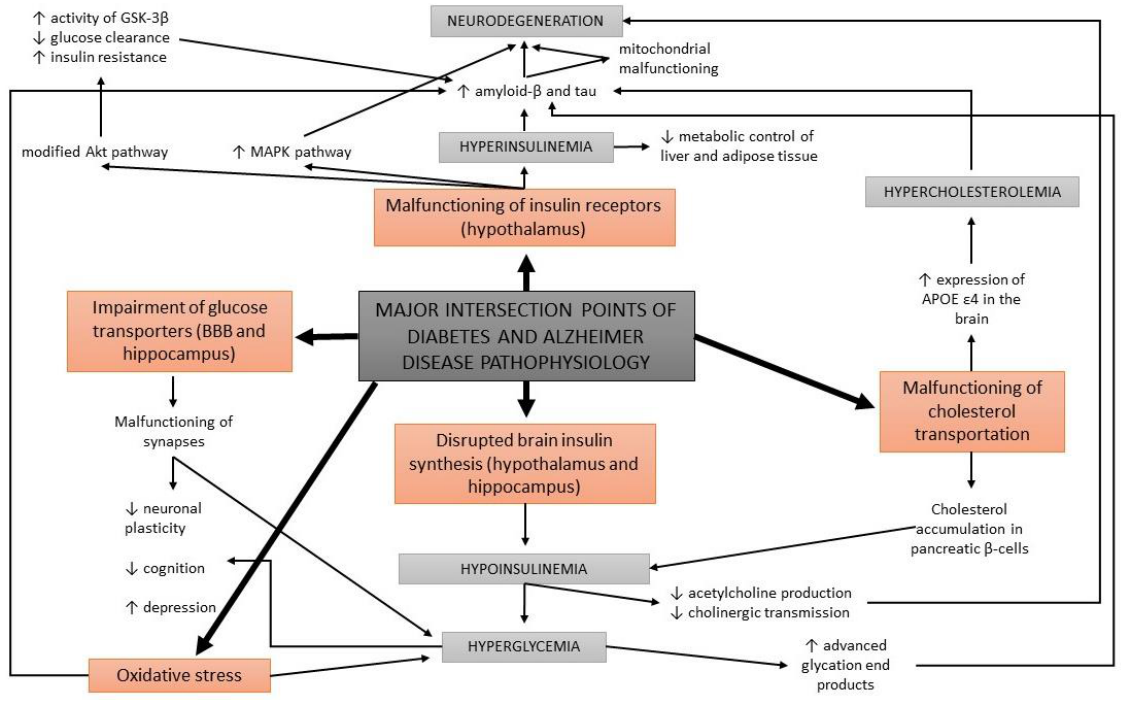
Figure 3. A schematic overview of the major intersection points of diabetes and Alzheimer’s disease pathophysiology.